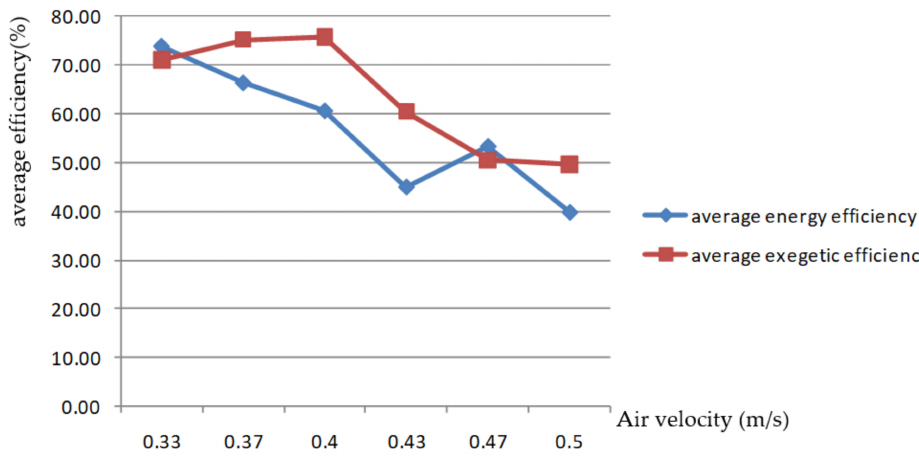
Figure 9. Changes in the average energy efficiency and exergy efficiency of the drying process with flow velocity of the drying medium.